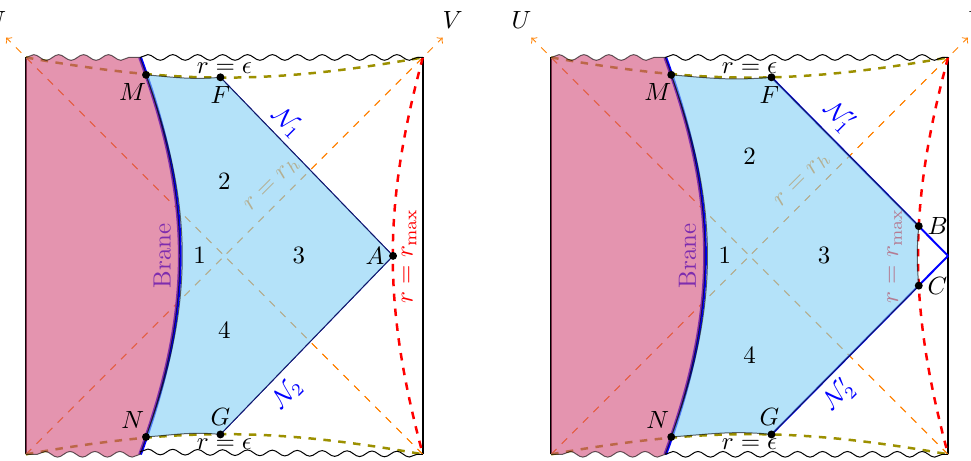
h < LTr max in the left) (cid:12)rst regular-